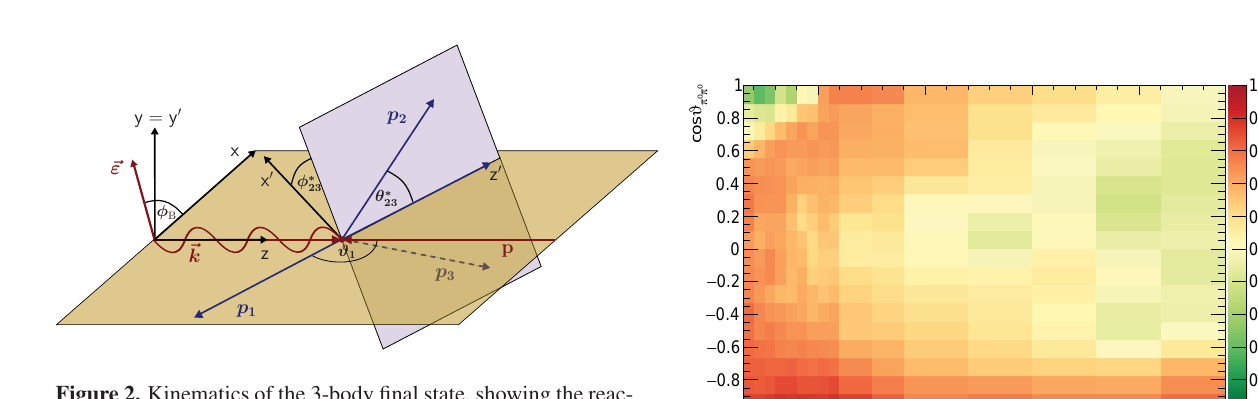
dence level ( > 0 . 1) acted as a joint mass cut on the pions and the missing proton.